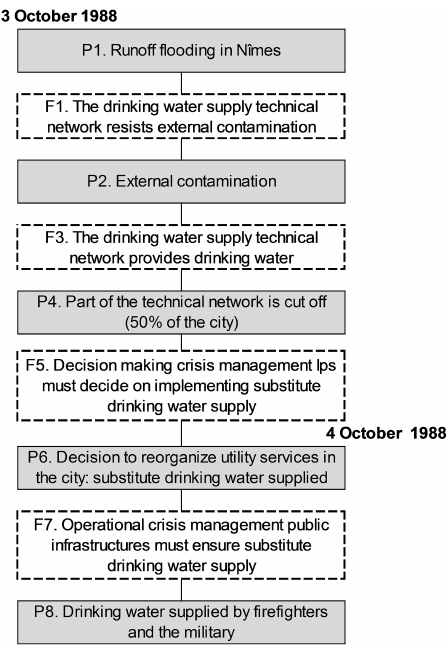
Figure 6. Representation of directed graph dynamic causal model for the 1988 crisis scenario in Nîmes, for drinking water supply technical